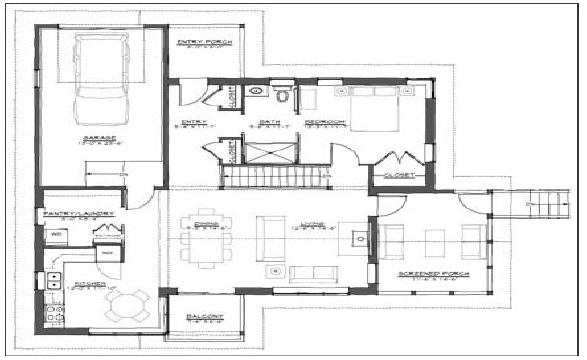
Figure 2. The Community Building, Upper Floor.